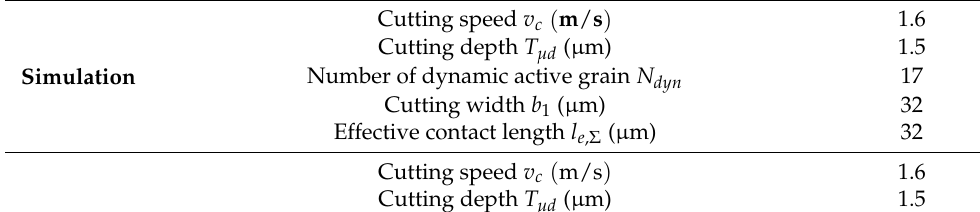
Table 4. Simulation and experiment parameters.